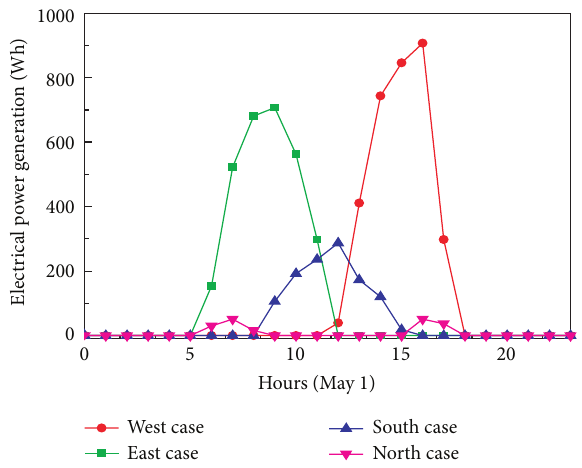
Figure 10: Daily electrical power generation of west, east, south, and north cases.